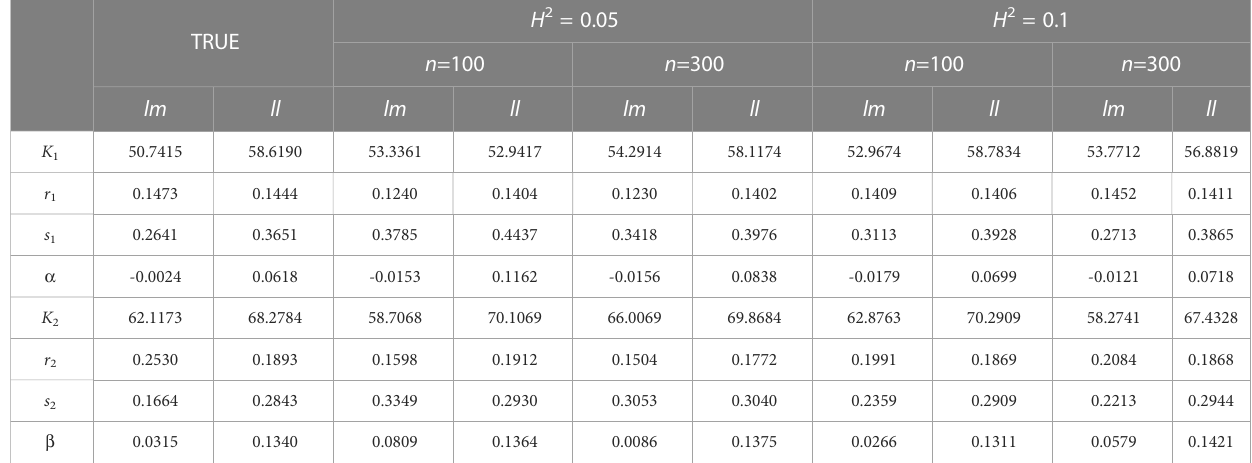
TABLE 2 Comparison between the real parameter set and the parameter set of simulation experiment results for stem length (mm) and taproot length (mm) . H 2 = TRUE